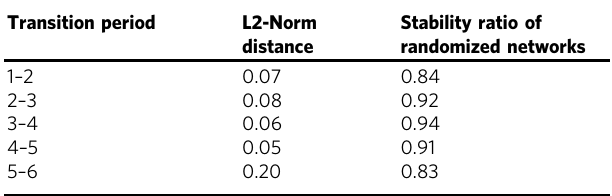
Each state is de fi ned as a vector of 16 probabilities. Stability test shows that at least 83% of transitions in each observed Markov chains are statistically signi fi cant compared to the ones computed from randomized networks